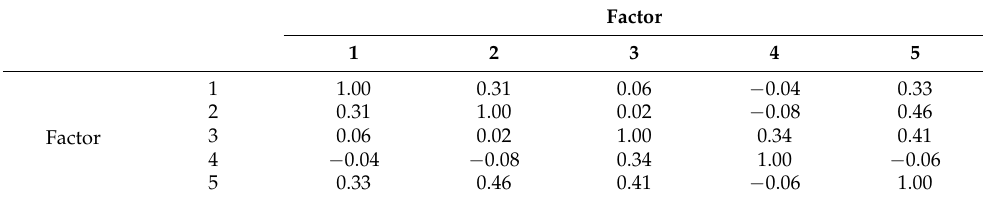
Table 4. The covariance